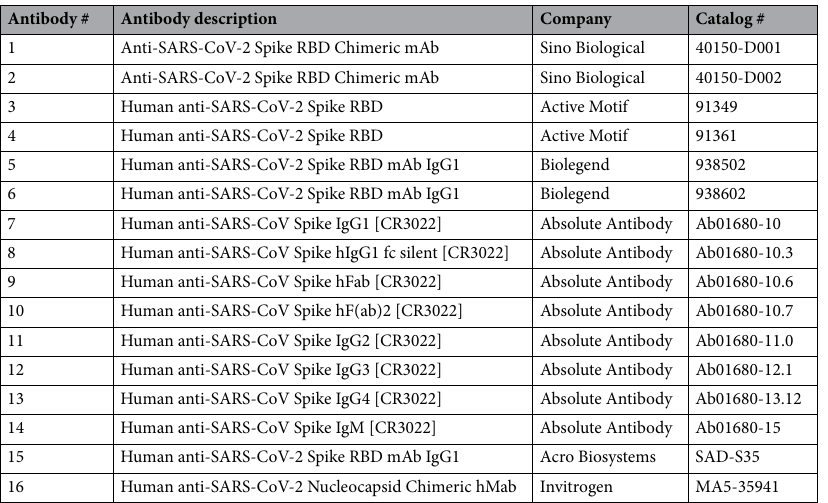
Table 1. List of anti-SARS-CoV-2 Spike protein antibodies used in this study.